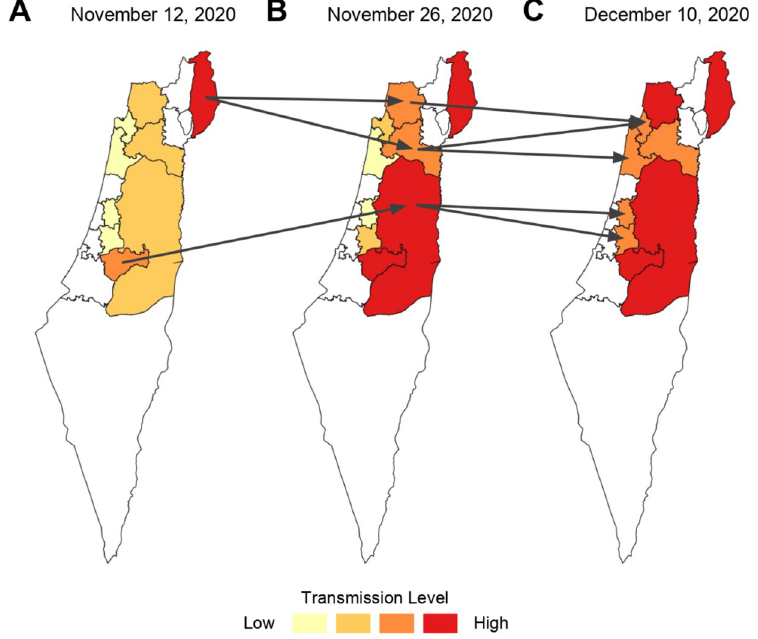
Fig 1. Association between movement between districts and epidemic severity for two two-week periods in late 2020. Arrows denote significant travel between regions over the two-week period. Epidemic severity is indicated by